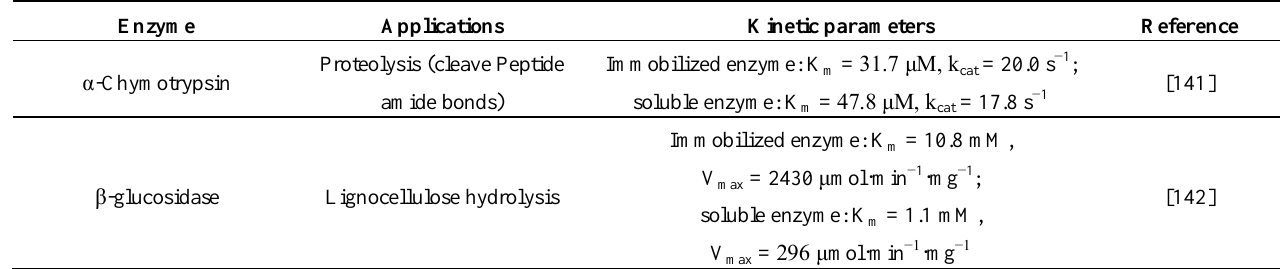
Table 2. Examples of immobilized enzymes with enhanced